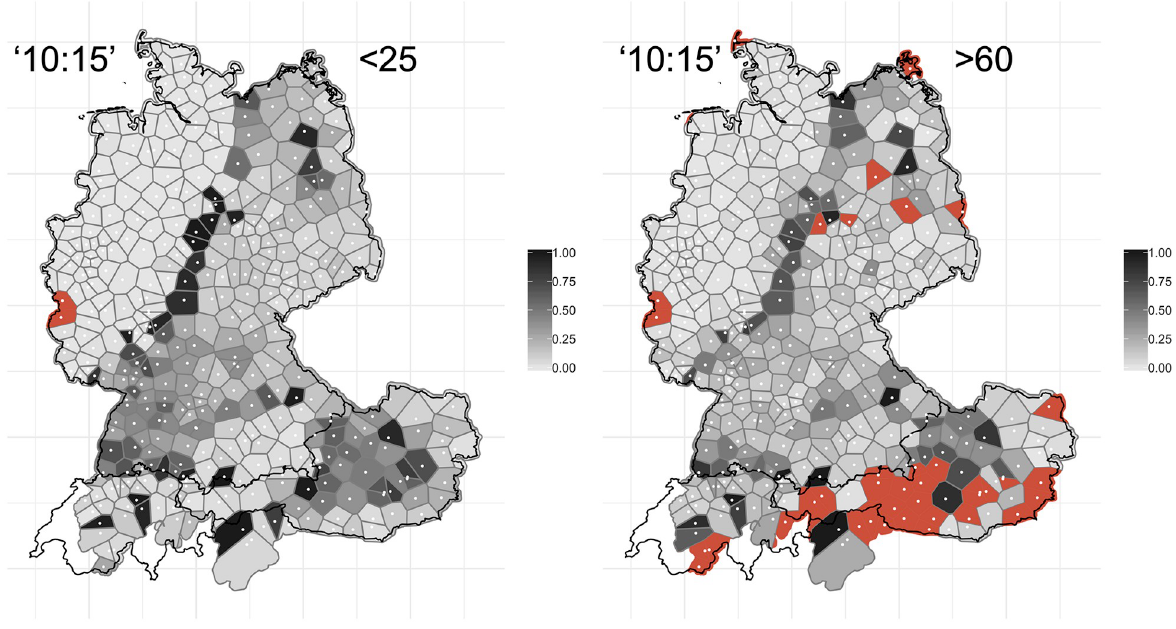
Fig 15. Degree of change maps for ‘10:15’. Users < 25 years old are shown on the left, users > 60 are shown on the right.